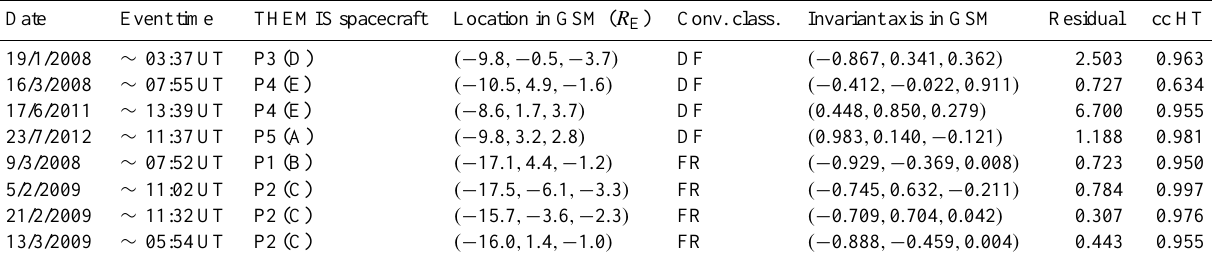
Table 1. Eight selected THEMIS events conventionally classified either as flux rope (FR) or dipolarization front (DF) registered at various radial